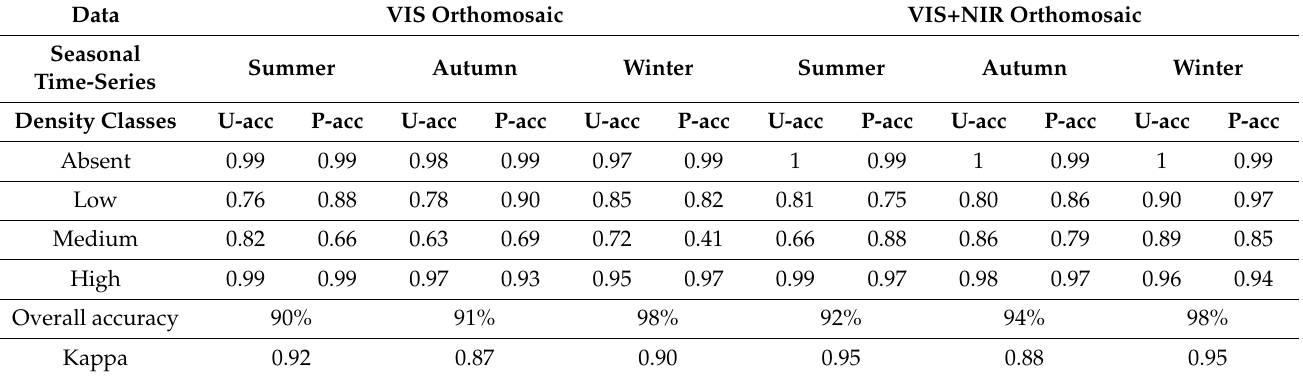
Table 1. The accuracy assessment of seasonal time-series seagrass classification for VIS and VIS+NIR orthomosaic, including the user accuracy “U-acc” and producer accuracy “P-acc,” and the overall accuracy for the classified features versus referenced data (“Overall Accuracy”) and the Kappa coefficient. Kappa coefficient estimates of zero indicate a random association and increasing values towards one showing an increasingly no-random